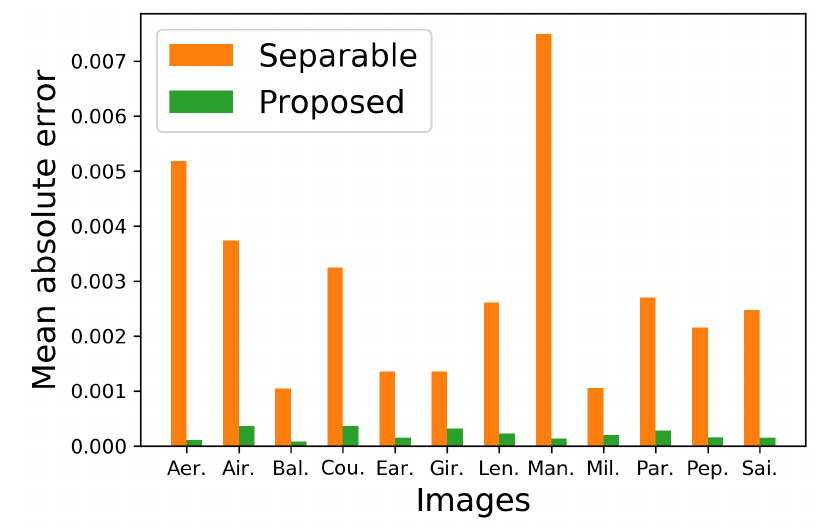
Figure 11. Mean absolute errors of halftoned SIDBA images in Figure